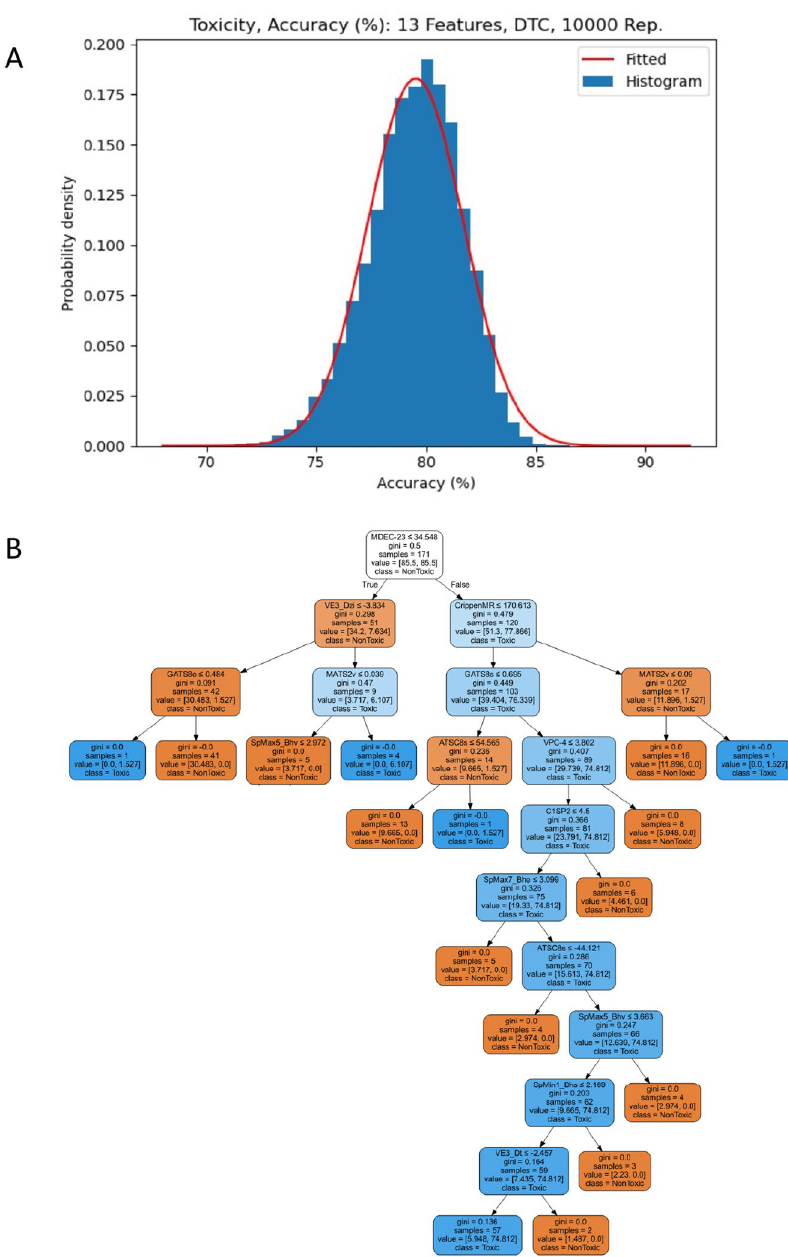
Figure 3. ( A ) Toxicity Dataset, histogram and fitted normal probability density function of the accuracies for 10,000 replications of DTC (Max. Depth, 10) applied to final 13 molecular descriptors. ( B ) Toxicity Dataset, DTC plot 70 , which is generated by graphviz.org, with maximum depth 10 trained on final 13